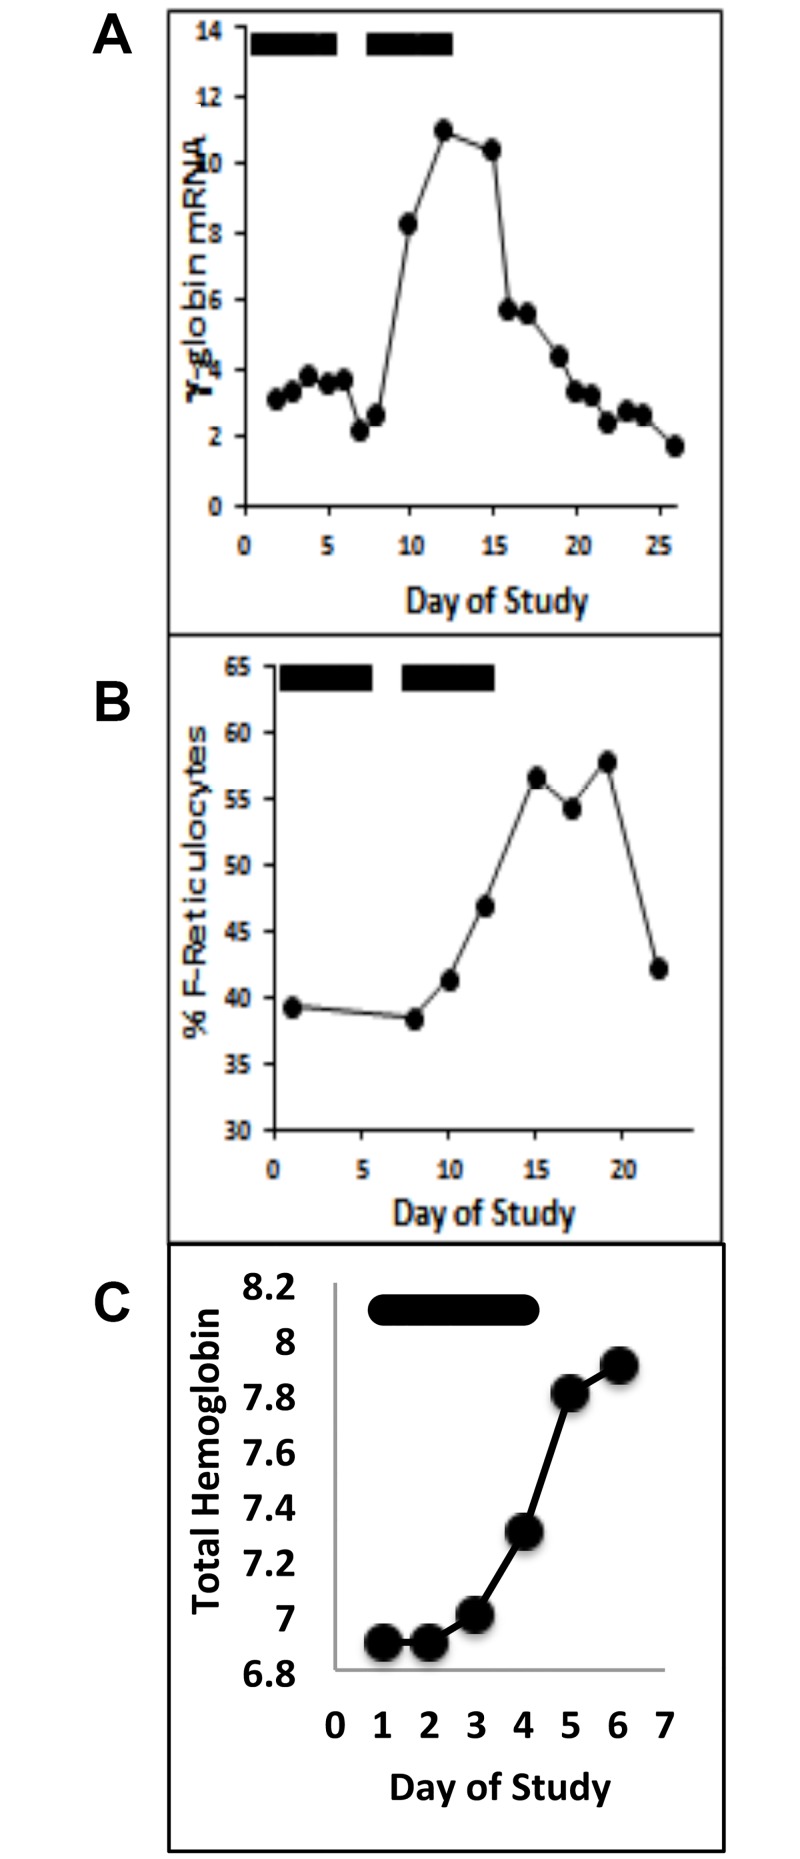
Fetal globin induction in an anemic baboon treated with Desloratidine (DLT).(A.) Treatment with DLT (once per day, 5 days/week), shown by the black bars above the graph, resulted in 5-to 11-fold induction in γ-globin mRNA, (B.) a 15% increase in F-reticulocytes, and (C.) a 1.0 gm/dL increase in total hemoglobin.